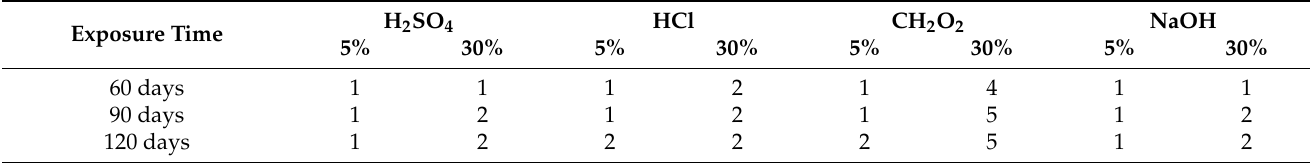
Table 8. Evaluation of the visual assessment of the chemical resistance of the NBR-CW coating.